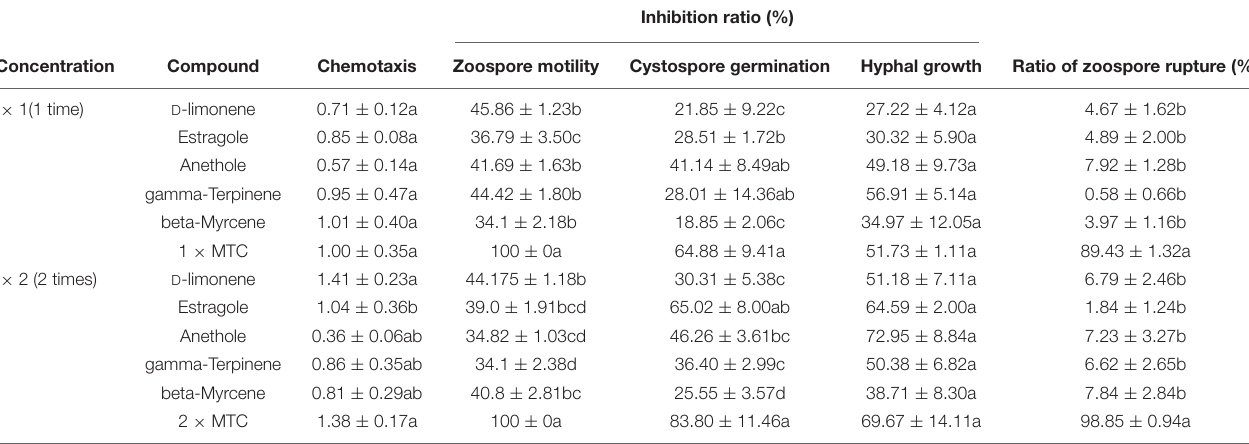
TABLE 2 | The antimicrobial activity of a mixture of five terpene compounds against Phytophthora capsici infection according to their concentrations in the rhizosphere soil of fennel.